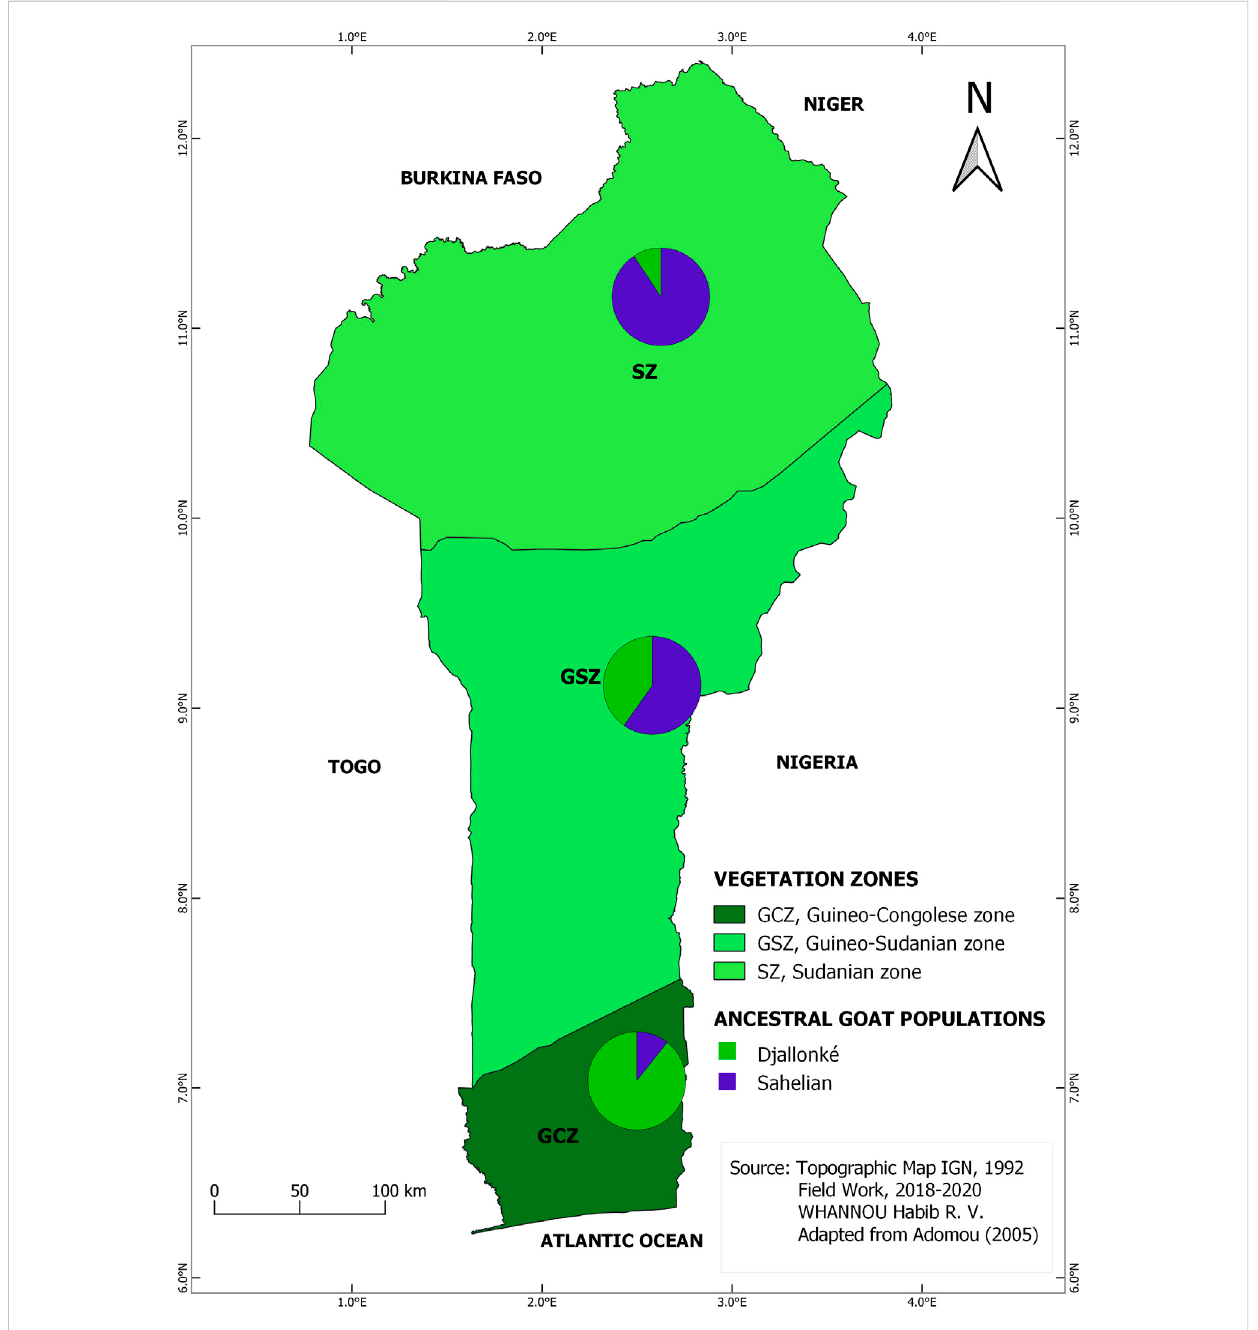
FIGURE 2 Map of the spatial distribution of the two inferred ancestral populations based on membership assignment from the population structure analysis following vegetation zones pattern.